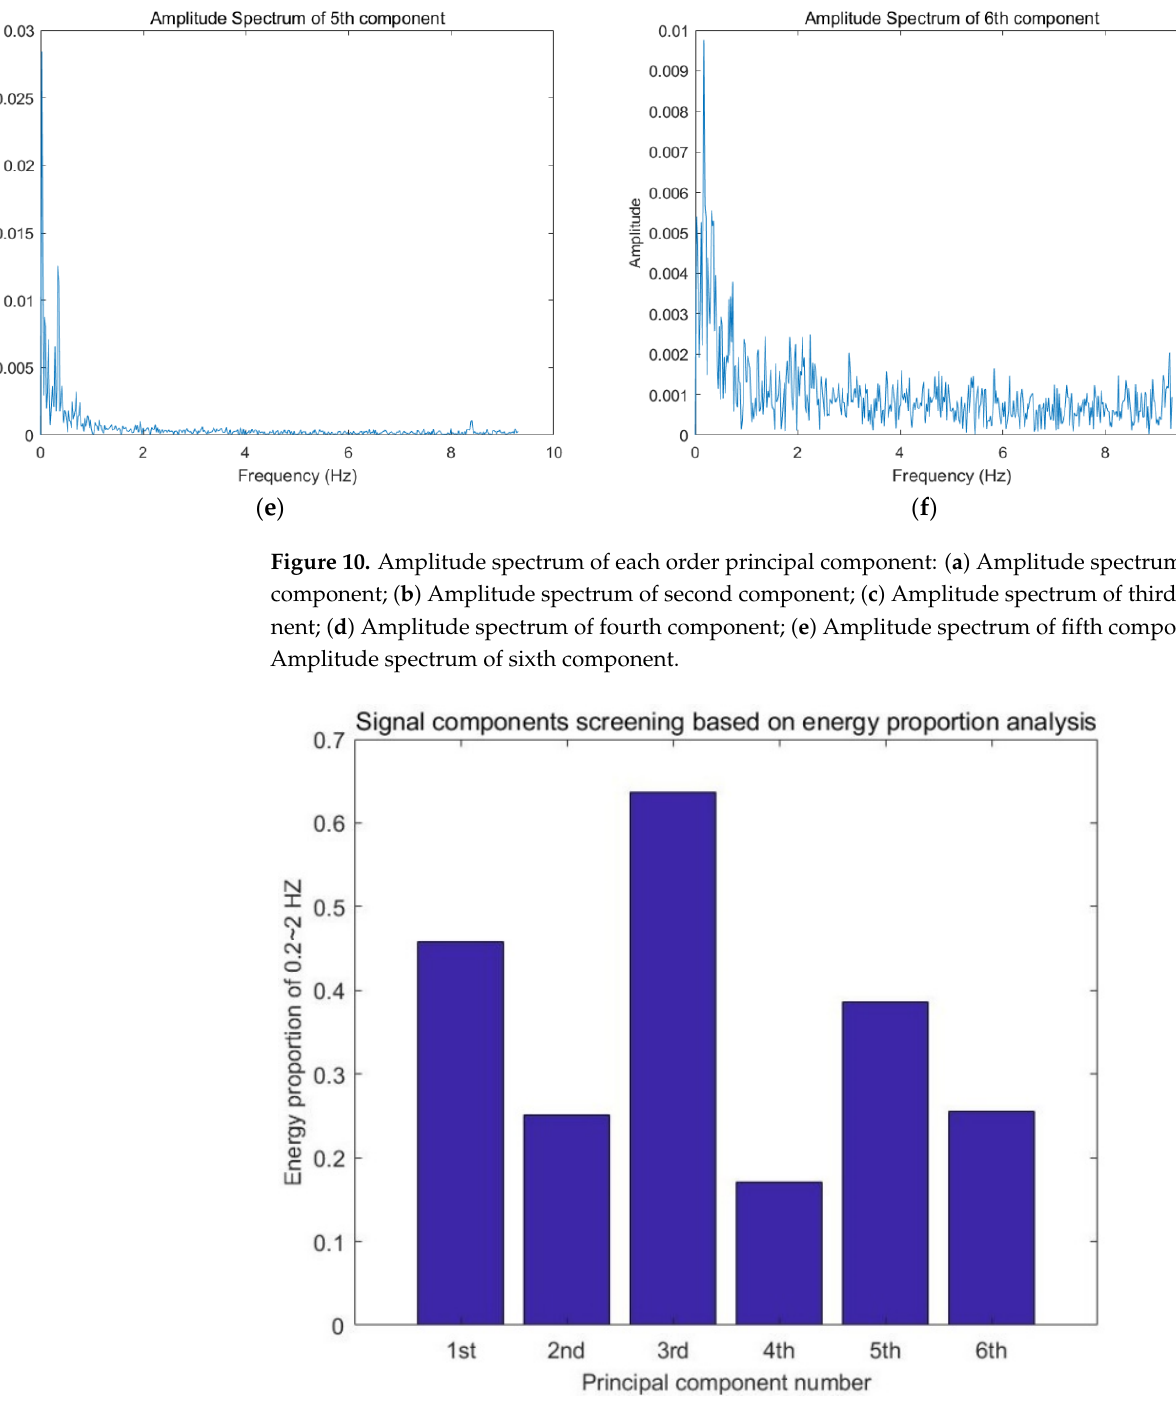
Figure 11. Energy proportion diagram of vital signs frequency band.